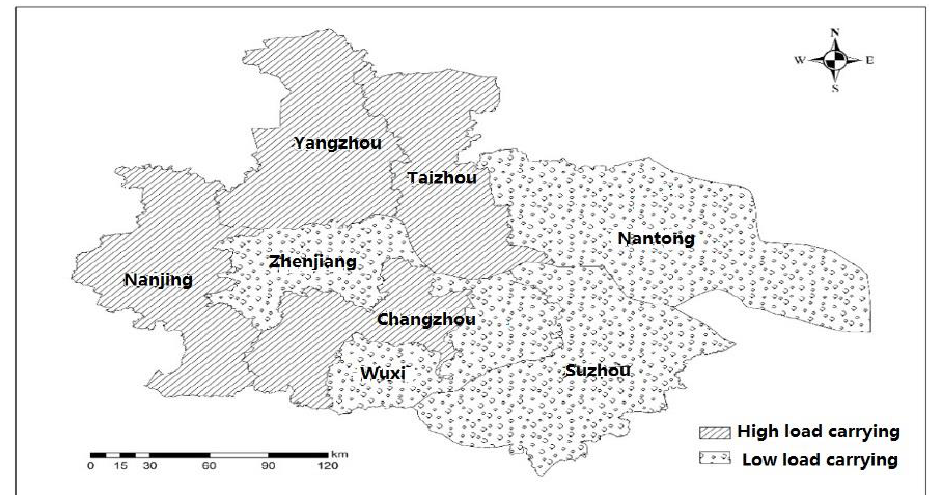
Figure 5. Spatial distribution map of the comprehensive indices of ecological carrying capacity by city.